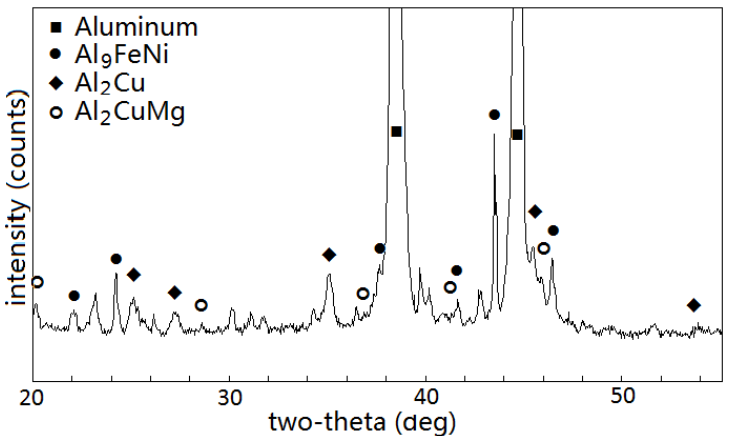
Figure 2. X-ray diffraction spectra of the Sample FC.